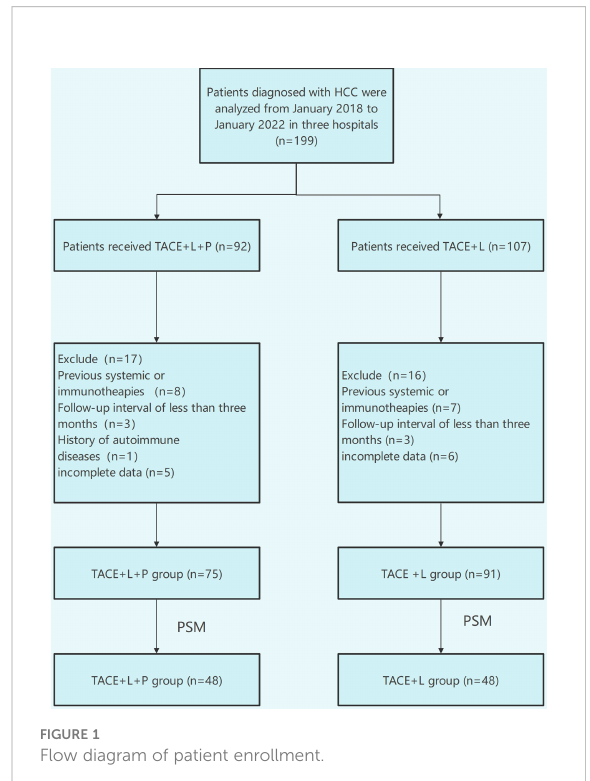
FIGURE 1 Flow diagram of patient